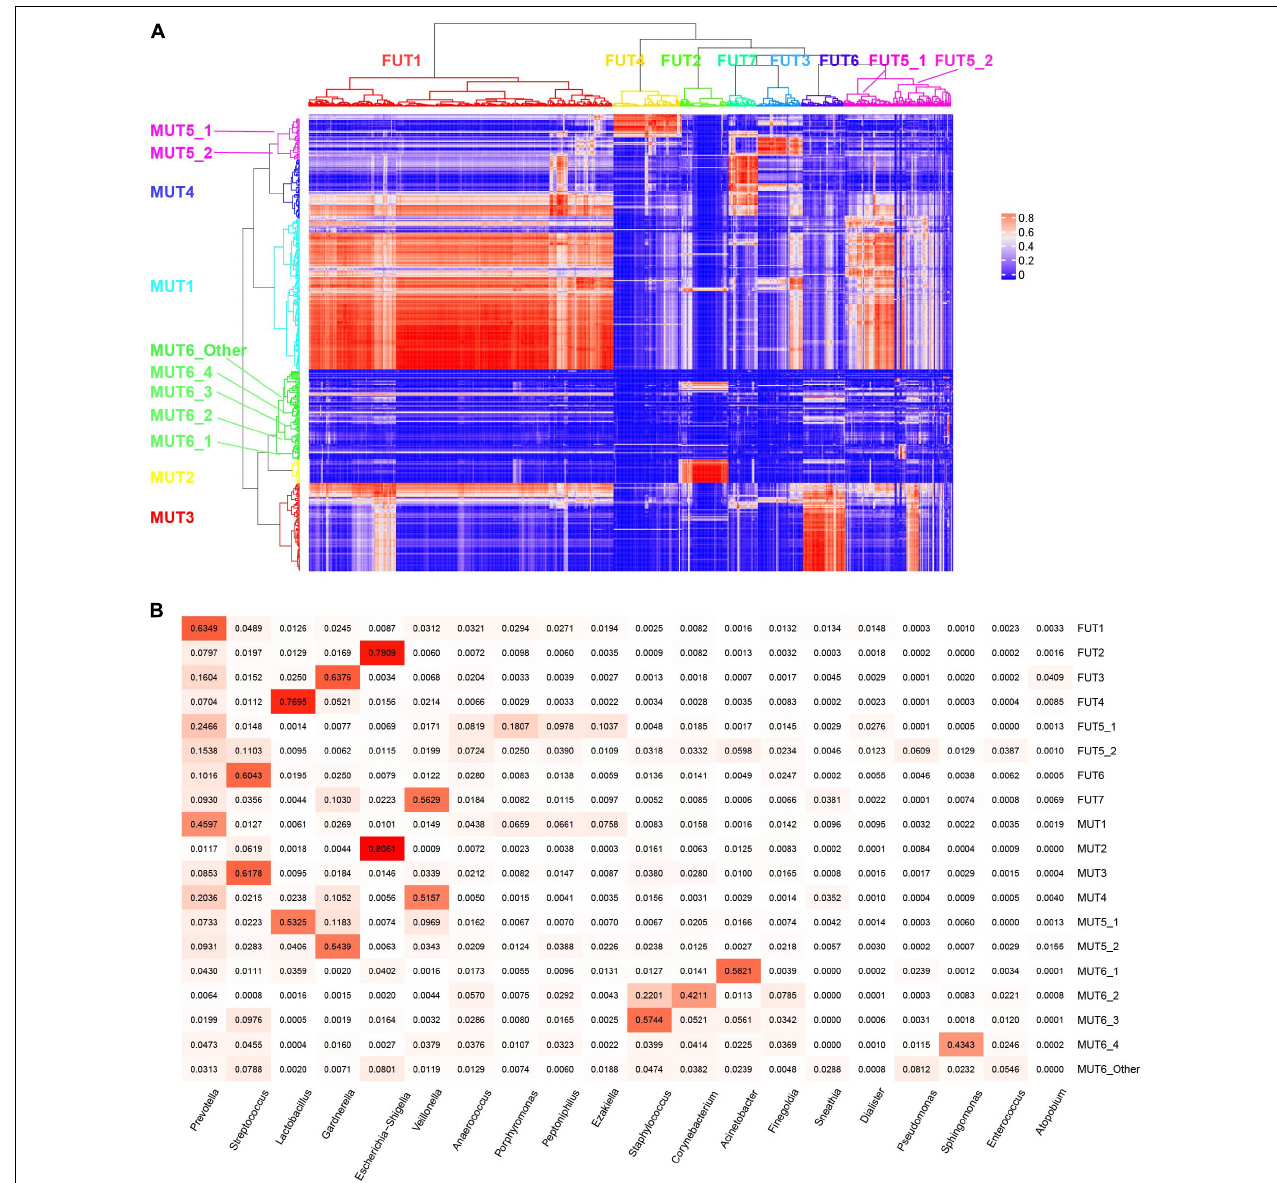
FIGURE 5 | Characteristics of each urotype. (A) Correlation of relative abundance between female and male urotypes. (B) Heatmap showing the mean relative abundance of representative genera for each urotype.